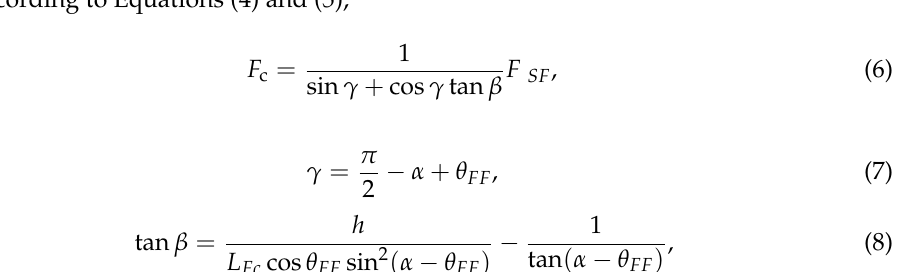
where F c is the contact reaction between the finger and fruit, that is the finger gripping force; γ is the angle between F c and the horizontal direction; β is the angle between F SF and the horizontal